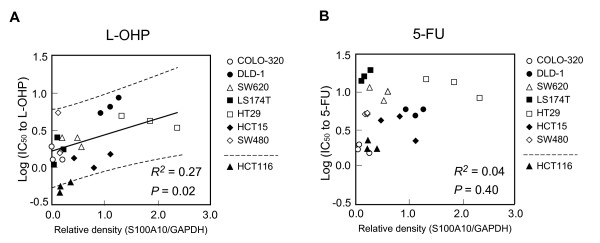
Relationship between S100A10 protein expression levels and sensitivity to L-OHP or 5-FU. The S100A10 protein expression level is associated with L-OHP sensitivity (P = 0.02, R2 = 0.27) (A), but not with 5-FU sensitivity (P = 0.40, R2 = 0.04) (B). The relationship between the sensitivity to L-OHP or 5-FU and S100A10 protein expression levels in 7 cell lines which were used in the candidate search were examined by the linear regression analysis. Twenty-one experimental data points (3 separate experiments with each of 7 cell lines) of the index data set and 3 experimental data points of HCT116 as a testing sample are plotted. Linear regression line (solid line) and 95% prediction interval (dotted line) are depicted.